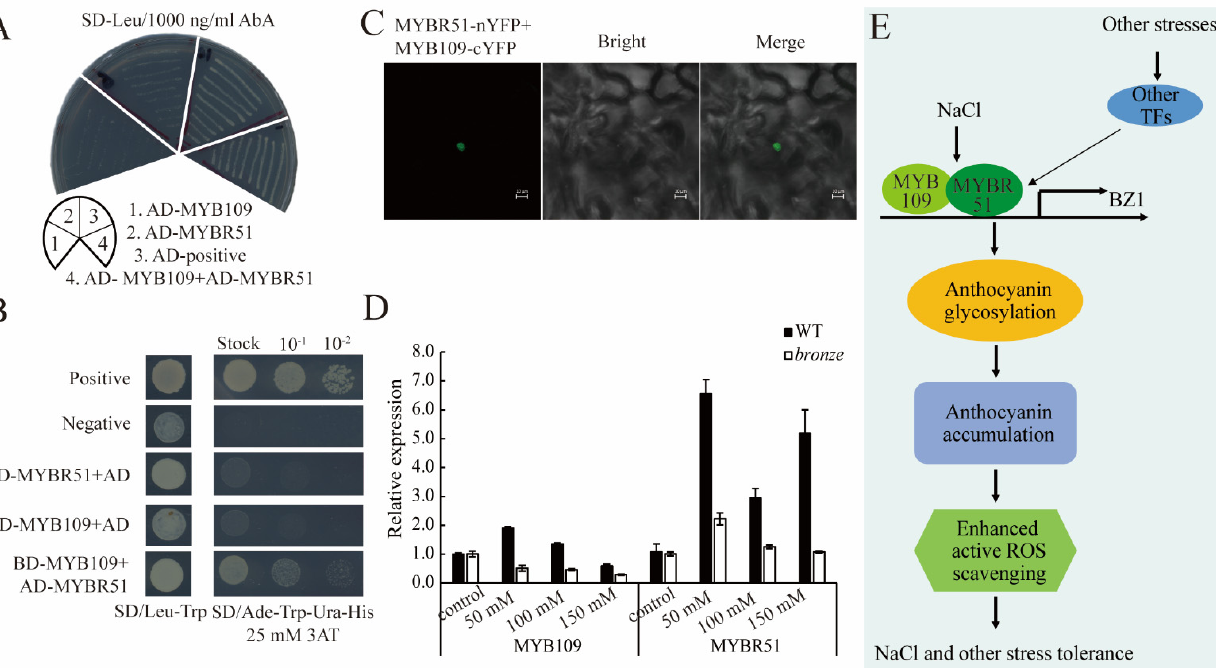
Figure 8. ZmBZ1 was regulated by complex of MYBR51/MYB109. ( A ) Y1H showing that MYB109 and MYBR51 work together on the ZmBZ1 promoter; ( B , C ) Transcription factors MYBR51 and MYB109 were physically interacted with each other by conformation with Y2H and BiFC. Bar = 10 µ m; ( D ) MYB109 expression in WT was slightly induced by the salinity stress, especially under 50 mM NaCl; For MYBR51 , the expression was dramatically induced in WT by the salinity stress especially under 50 mM and 150 mM of NaCl, a slight inducement was observed in bronze mutant under 50 mM NaCl; ( E ) Schematic model of the genetic and environmental regulation of the anthocyanins in stress tolerance.